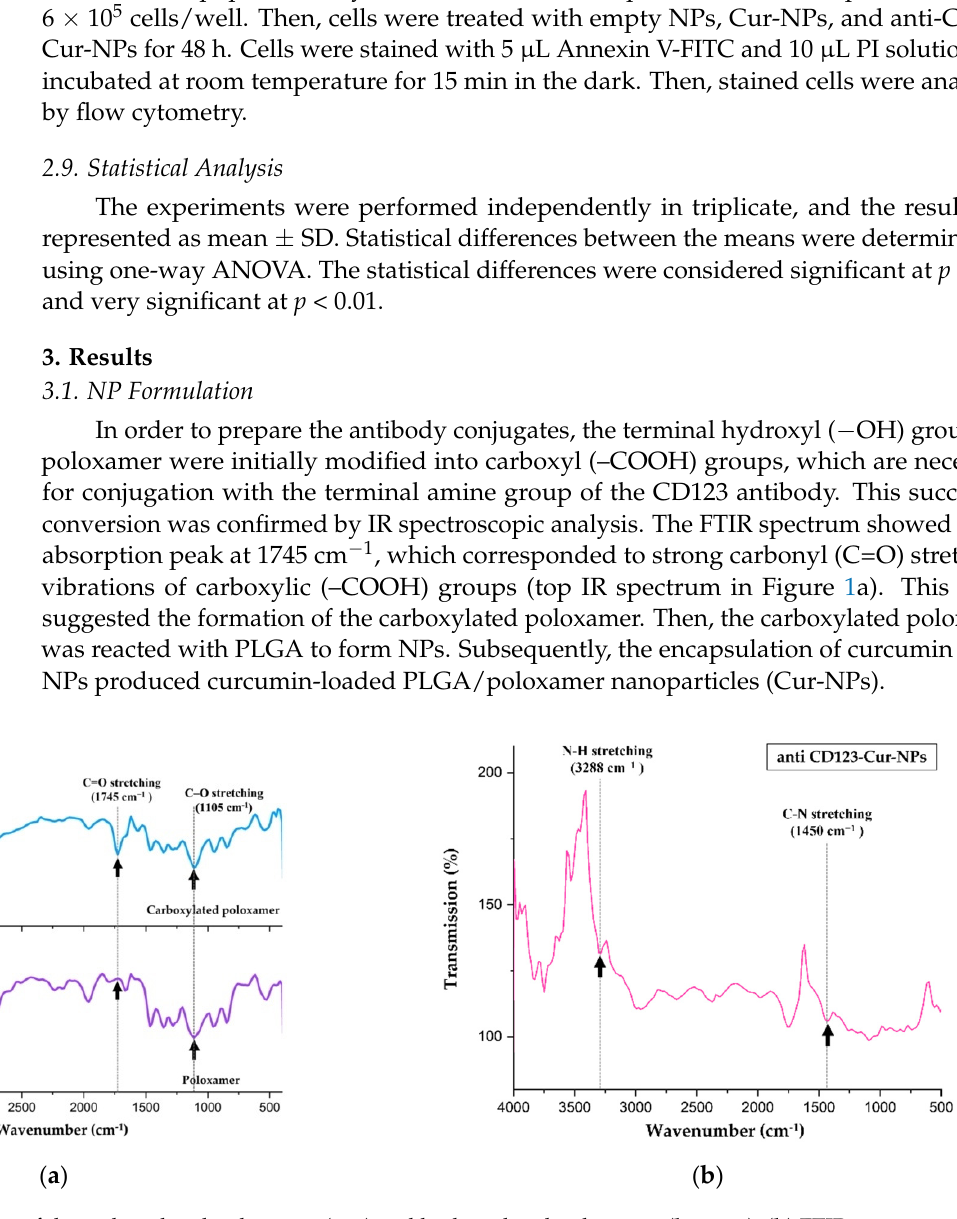
Figure 1. ( a ) FTIR spectra of the carboxylated poloxamer ( top ) and hydroxylated poloxamer ( bottom ); ( b ) FTIR spectrum of the anti-CD123-Cur-NP